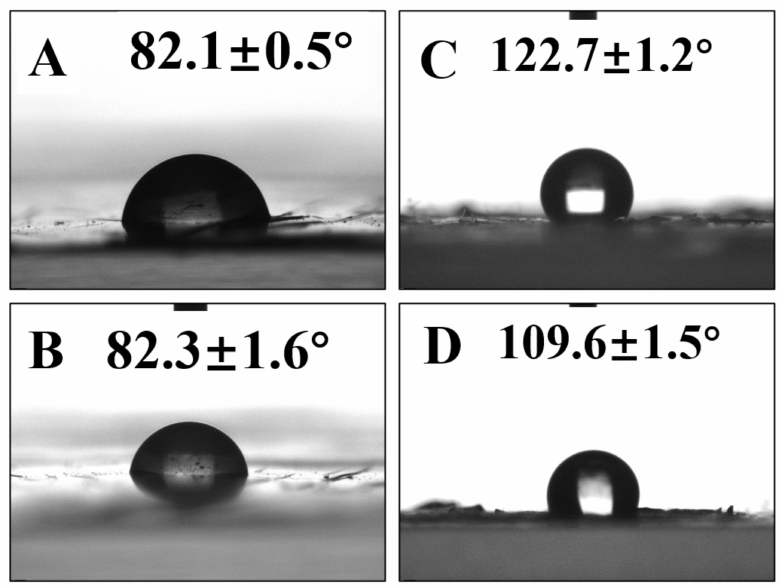
Figure 3. Water contact angles of reference ( A , B ) and W-CM ( C , D ), observed from Direction a ( A , C ) and b ( B , D ),